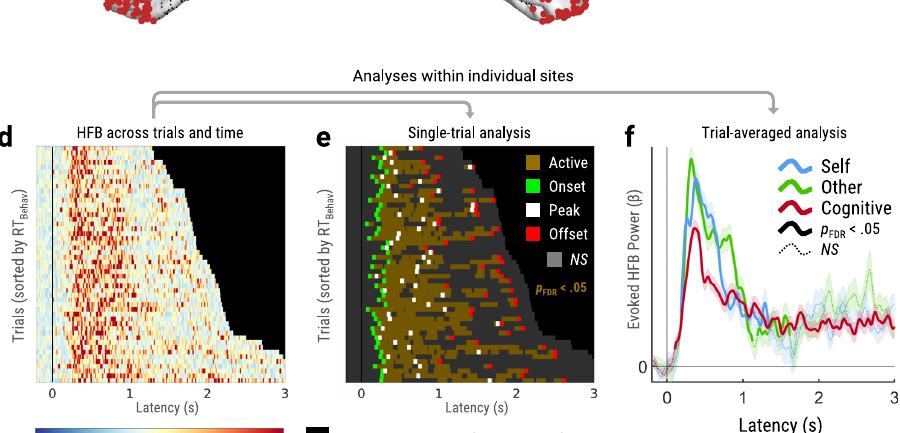
Mentalizing activations propagate from visual cortex to mPFC . Next, we explored the timing of mentalizing-evoked activations across ROIs. To this end, we analyzed single-trial HFB latency metrics from mentalizing-active ROI sites (Fig. 3e). Pairwise ROI comparisons (Fig. 3f) measured trial-by-trial ROI differences